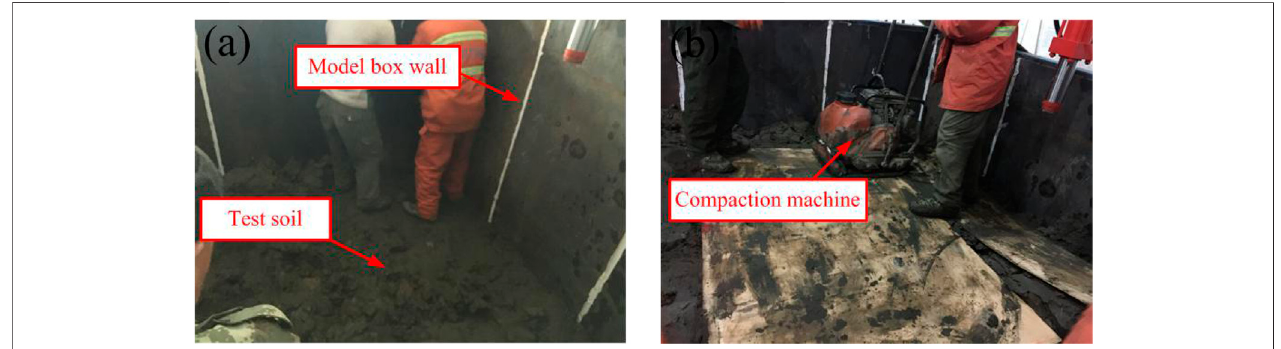
FIGURE 4 | The process of soil preparation: (A) Soil fi lling, (B) Soil compaction.